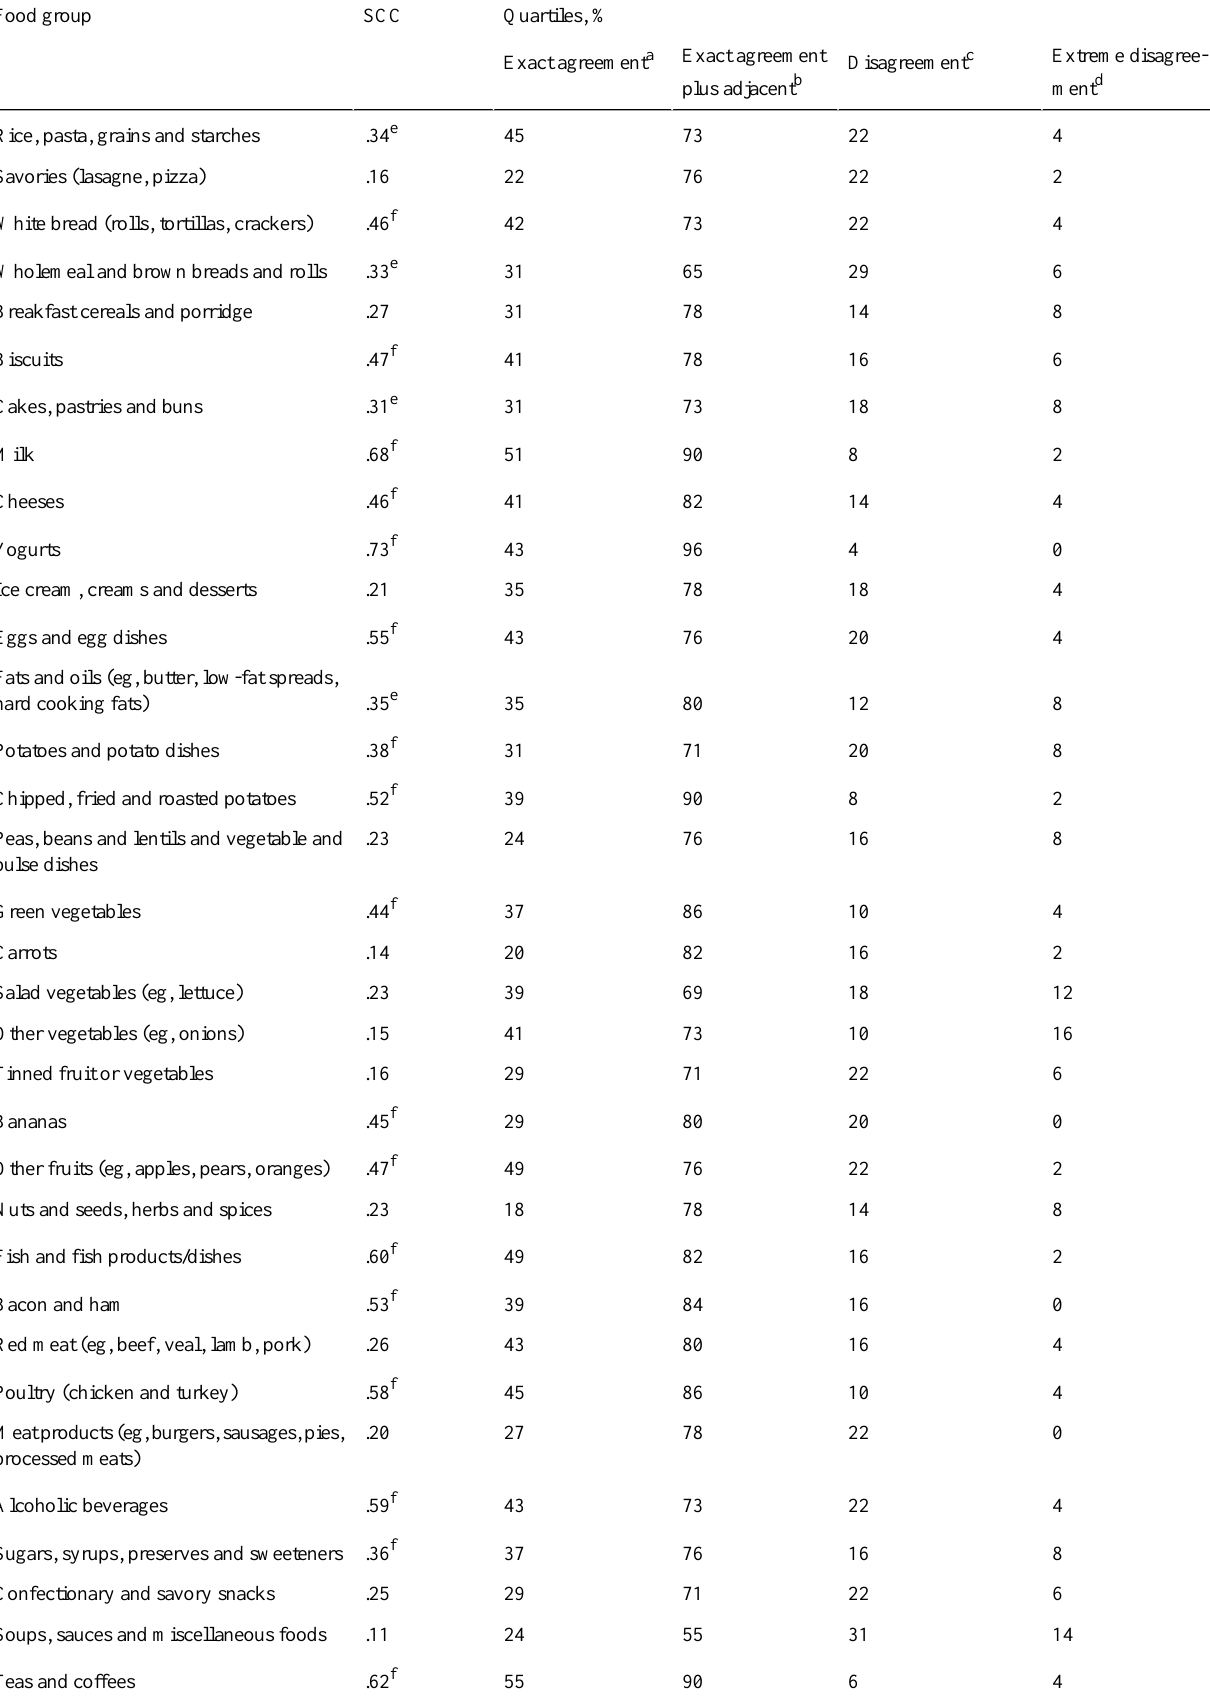
Table 7. Spearman correlation coefficients (SCC) and cross-classification of quartiles of food group intake derived from the online Food4Me FFQ and 4-day WFR